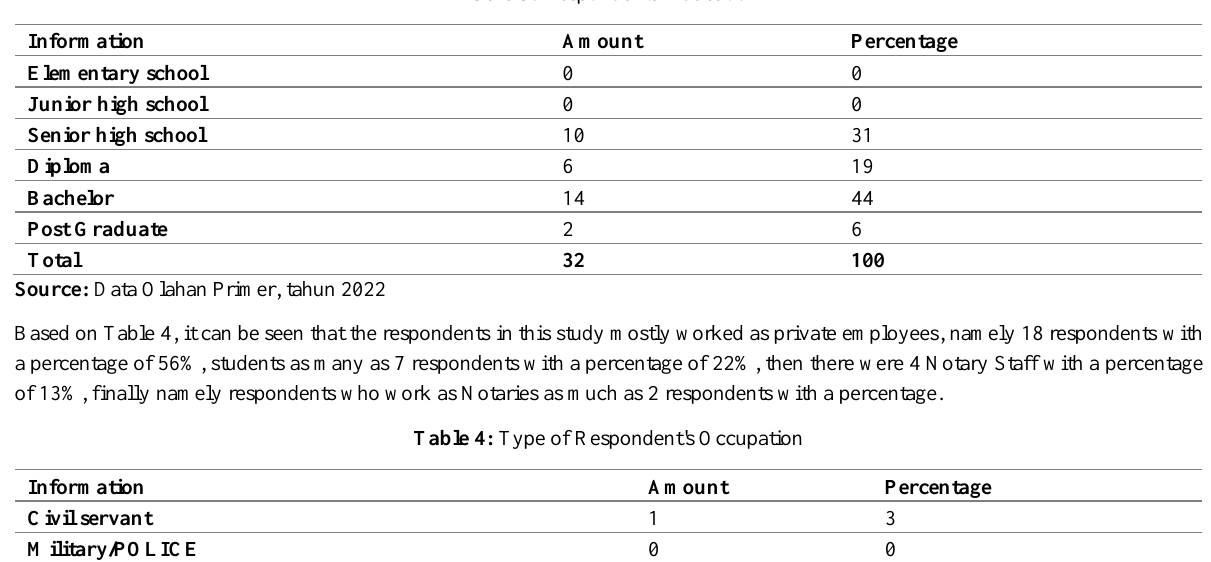
Table 3: Respondents' Education